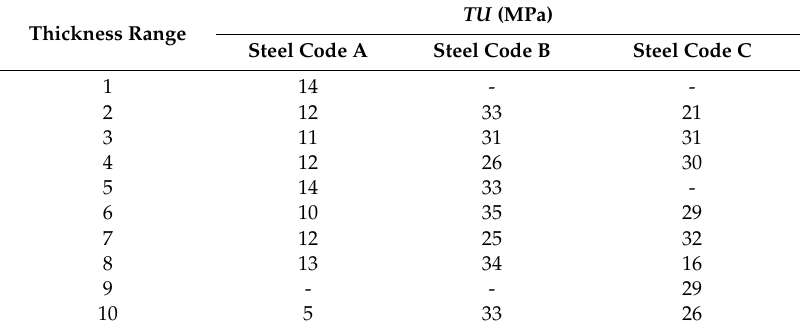
Table 3. Selected input variables for the models related to steel grade A for the thickness ranges with a sufficient number of data. Table 4. Values of the uniformity threshold UT for all the 25 FFNN-based